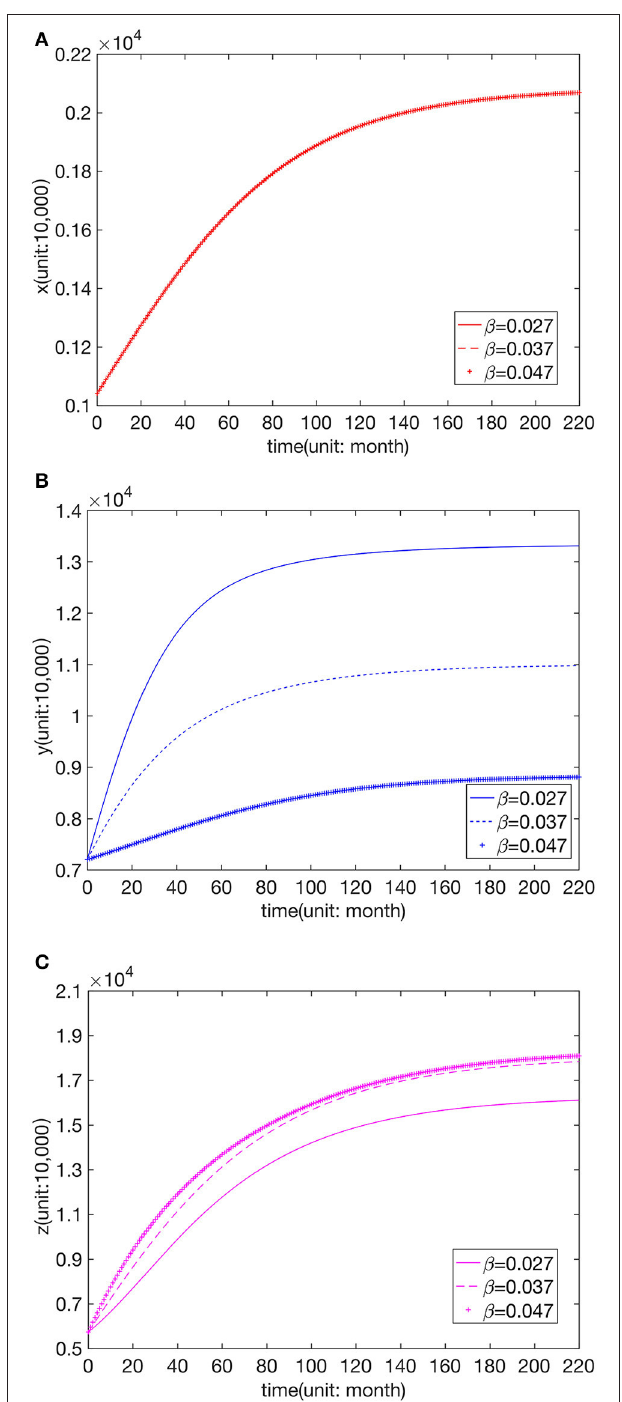
FIGURE 3 | Effect of parameter value α on the number of visits to (A) FLHs, (B) SLHs, and (C) TLHs.